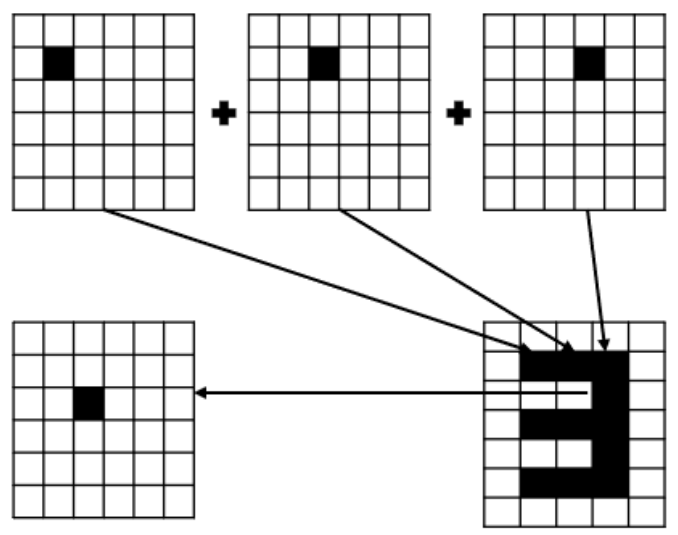
Figure 5. Relationship between complex objectives and essential elements.